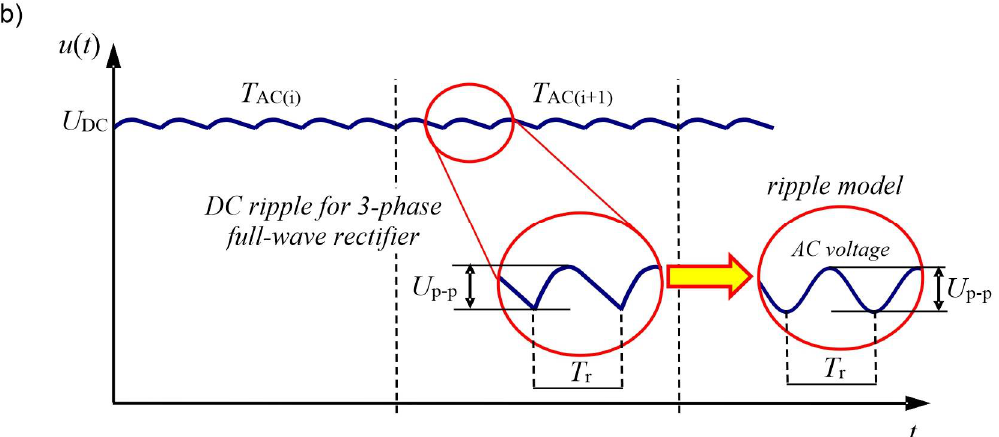
Figure 1. Measurement methodology and synchronization possibilities in HVDC networks for phase-resolved PD measurement: ( a ) concept and block diagram, ( b ) DC voltage with a single AC component as DC voltage with model ripple.